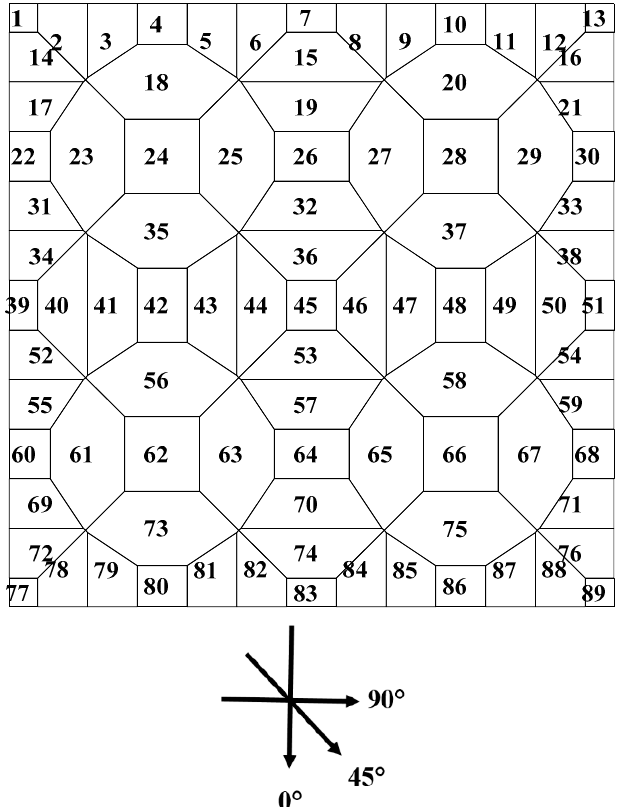
Figure 2. Thiessen polygons distribution.